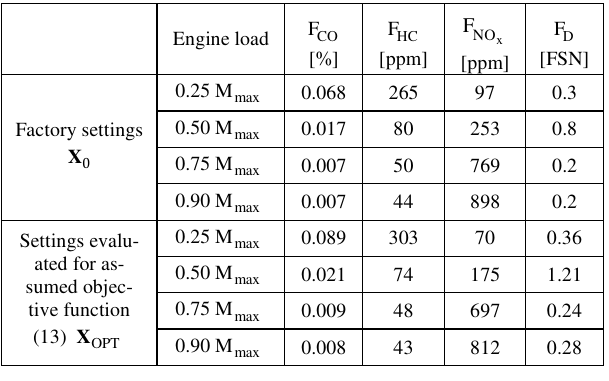
Table 5. Emissions of harmful exhaust gases in analyzed points of engine operation